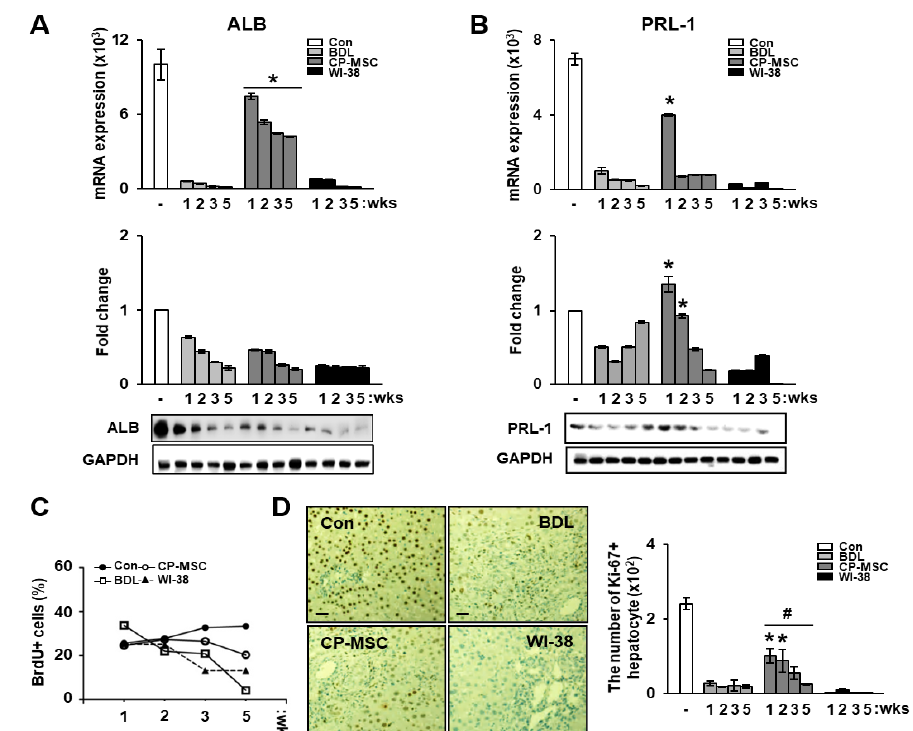
Figure 4. Effect of CP-MSCs on the proliferation of damaged rat hepatocytes in vivo and in vitro. mRNA and protein levels of ( A ) albumin (ALB) and ( B ) PRL-1 in hepatocyte-only extracts isolated from a BDL-injured rat model after cell transplantation were analyzed by qRT-PCR (upper) and Western blotting (lower). Equal amounts of RNA and protein were pooled in each group. GAPDH was used as an internal control. ( C ) BrdU-positive hepatocyte cells isolated from BrdU-injected BDL rats were gated and quantified using mouse anti-BrdU in normal, BDL, CP-MSC transplantation, and WI-38 transplantation groups at 1, 2, 3, and 5 weeks after cell transplantation. ( D ) Localization and quantification of Ki-67-positive hepatocytes in the BDL model after transplantation of CP-MSCs and WI-38 cells. Liver sections were stained using anti-rat Ki-67; Ki-67-positive signals (DAB chromogen in brown) were detected and counted using Image J software. The scale bar represents 75 µ m. Each experiment was repeated at least three times. The data are expressed as the mean ± SEM (* p < 0.05 compared with the BDL group; # p < 0.05 compared with the WI-38 transplantation group).